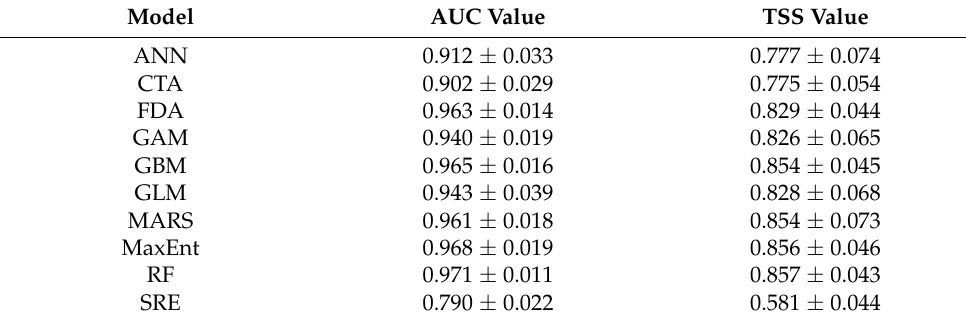
Table 2. Performance of ten ecological niche